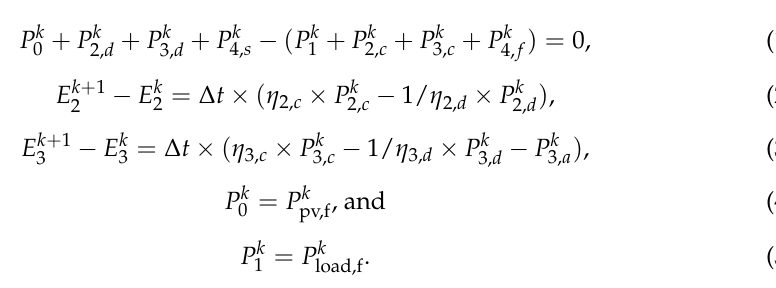
Figure 1. System architecture of the energy system under investigation and system components ( P k denoting power exchange and E k denoting energy content of component i at timestep k i